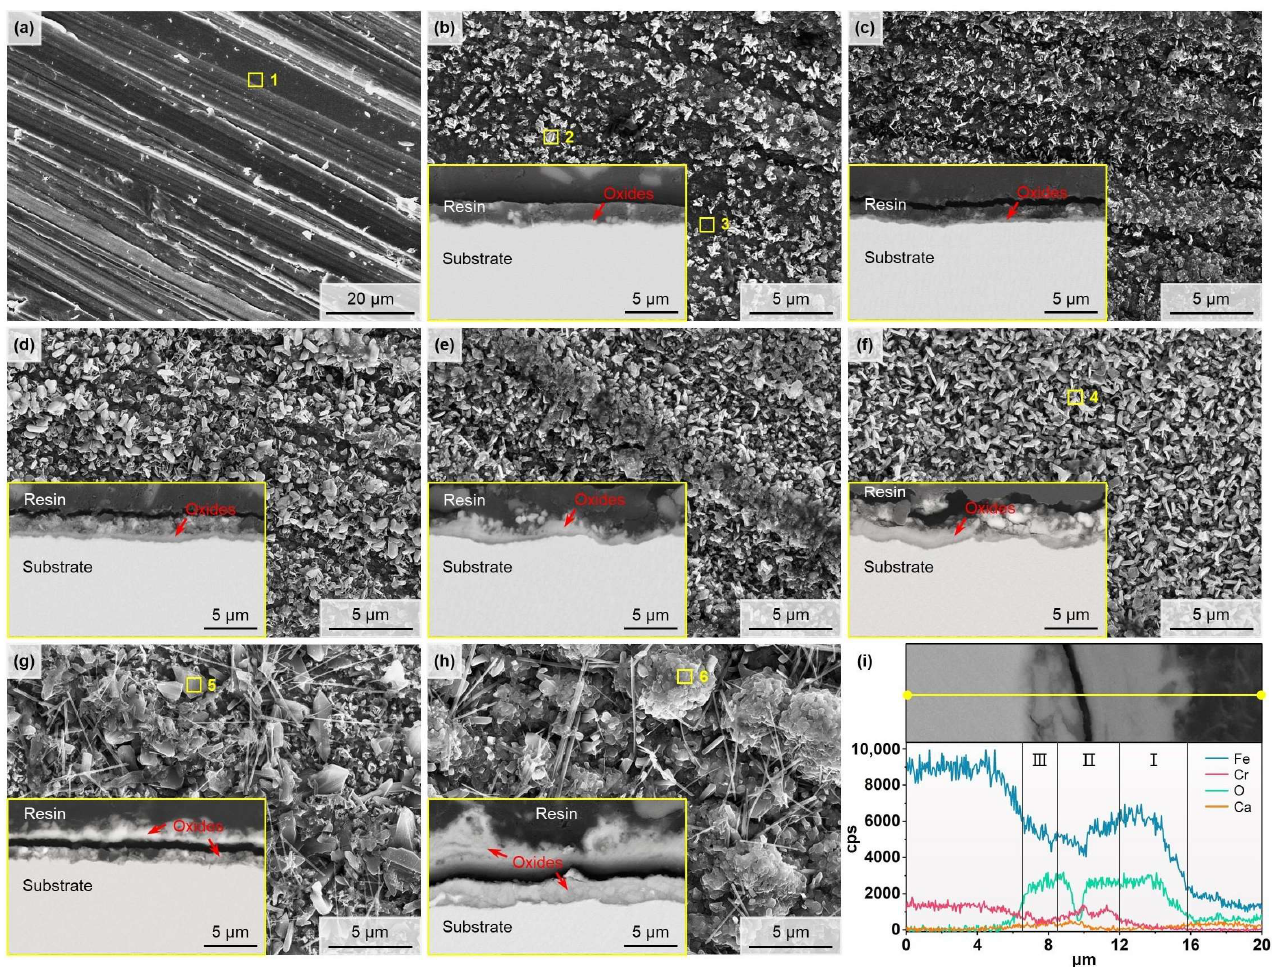
Figure 6. Surface and cross-sectional micrographs of P91 alloy exposed to Solar Salt at 565 °C for ( a )